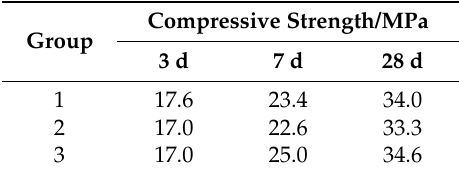
Table 2. Tested compressive strength of green